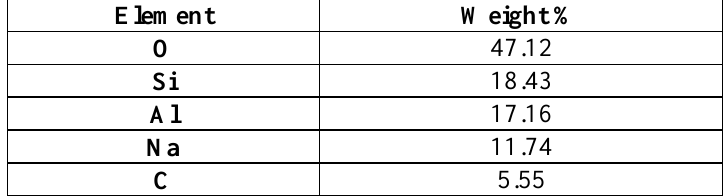
Fig.2: EDX spectrum of zeolite. Table 1: Elements analysis of